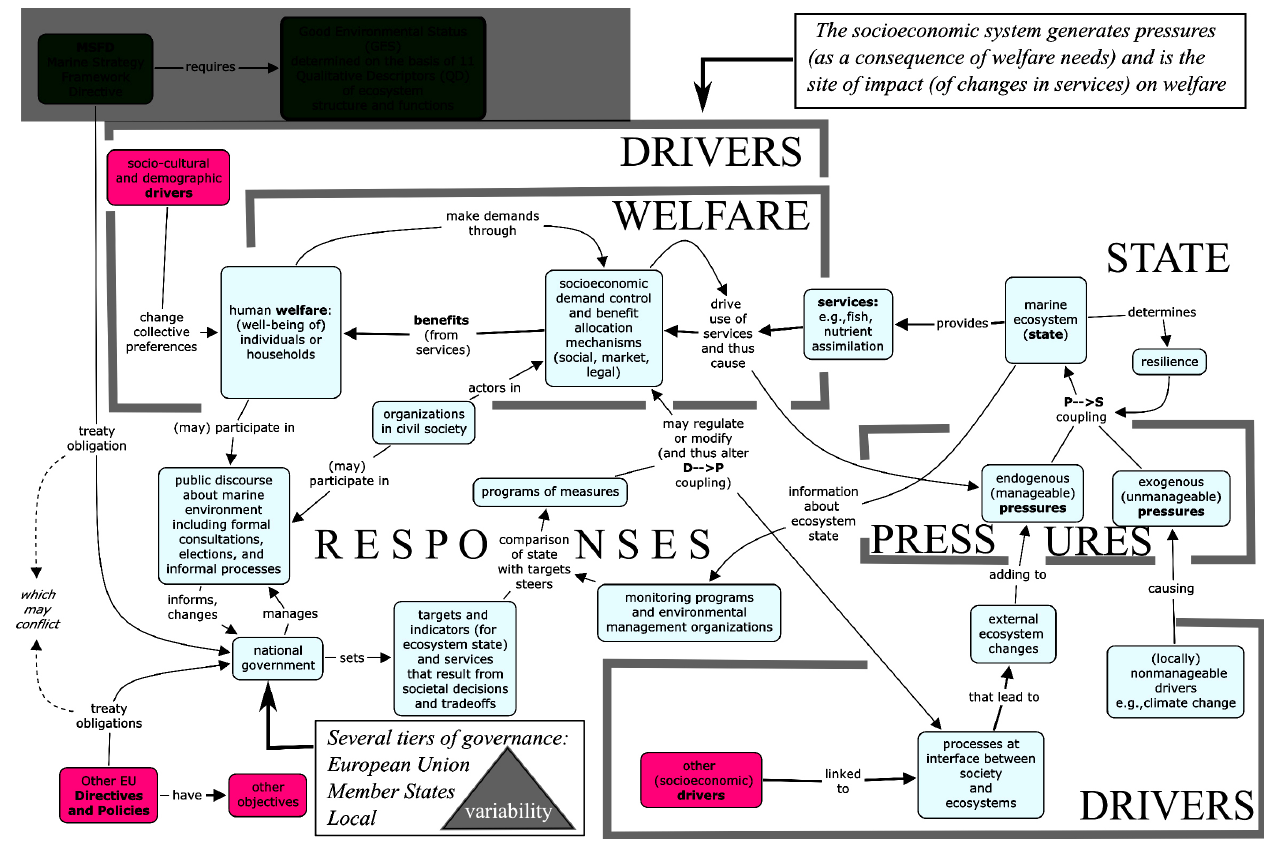
Fig. 3 . Conceptual model showing those elements of the DPSWR framework that have to be taken into account to achieve GEnS. The individual elements of the model are described in the